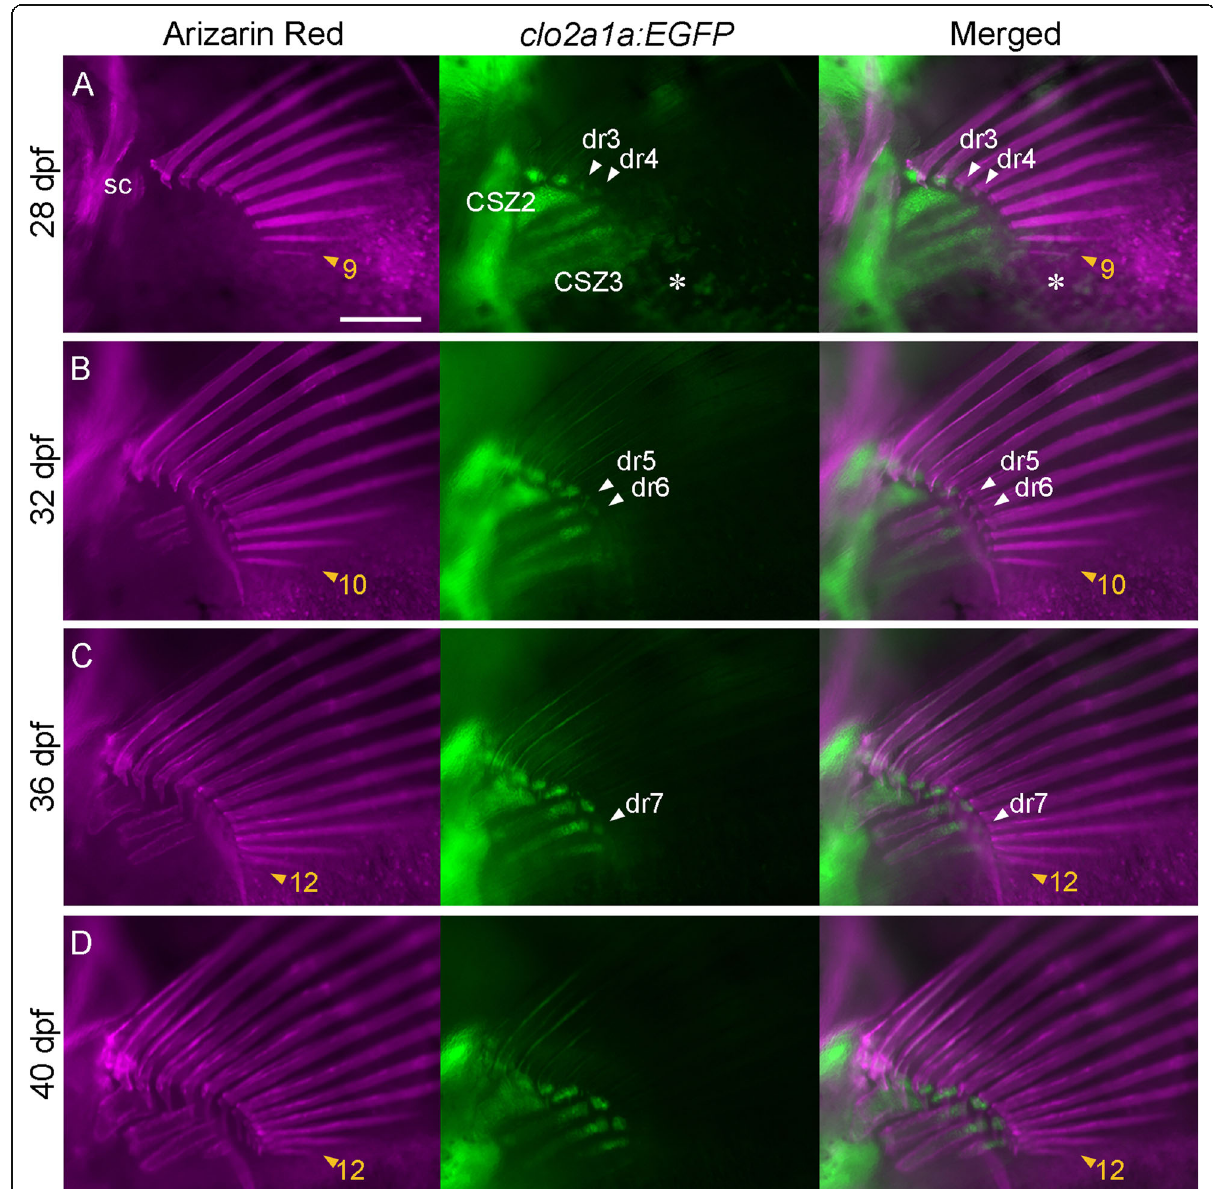
Fig. 4 Process of morphogenesis of the fin rays and radials. Calcified bones (Alizarin Red) and chondrogenic cells ( col2a:EGFP ) of the left pectoral fin in individual tracing specimens were observed at 28 dpf ( a ), 32 dpf ( b ), 36 dpf ( c ), and 40 dpf ( d ). The observed fish were crossbred. Orange arrowheads with numbers indicate the most posterior fin ray. White arrowheads with dr3 – 7 indicate newly appearing distal radials. The scale bar in a indicates 200 μ m. CSZ, cartilage subdivision zone. sc, anlagen of the scapula. The asterisk in a indicates the reflected signal of the